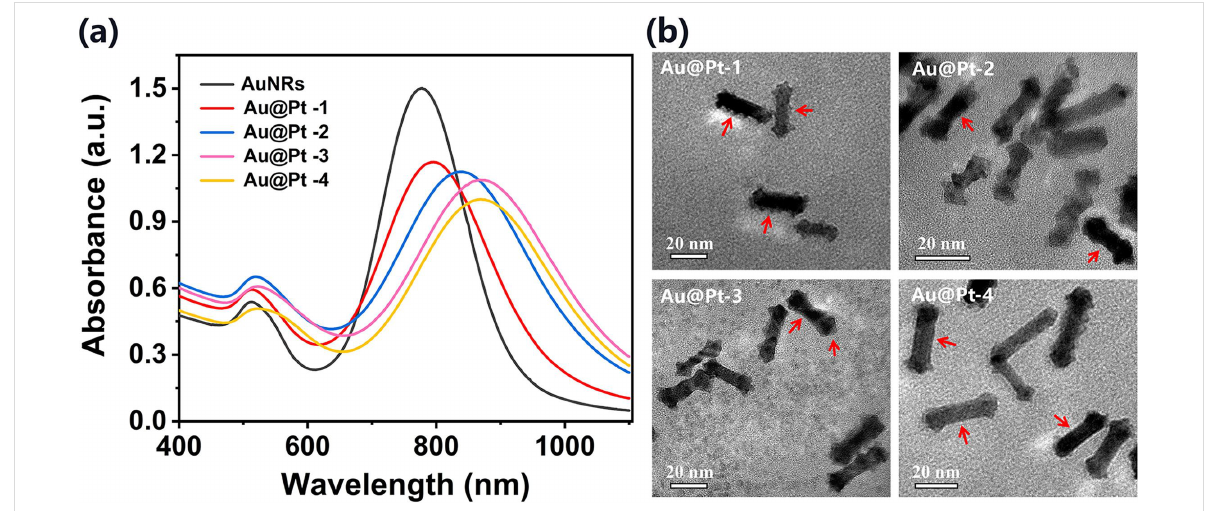
Figure 2: (a) Absorption spectra of AuNRs and of Au@Pt NRs synthesized with different concentrations of Ag + . (b) Corresponding TEM images of dif- ferent Au@Pt NRs. Annotation: Au@Pt-1, Au@Pt-2, Au@Pt-3 and Au@Pt-4 represent the Au@Pt NRs prepared with different concentrations of added AgNO 3 : 5, 10, 20, and 40 mM, respectively.